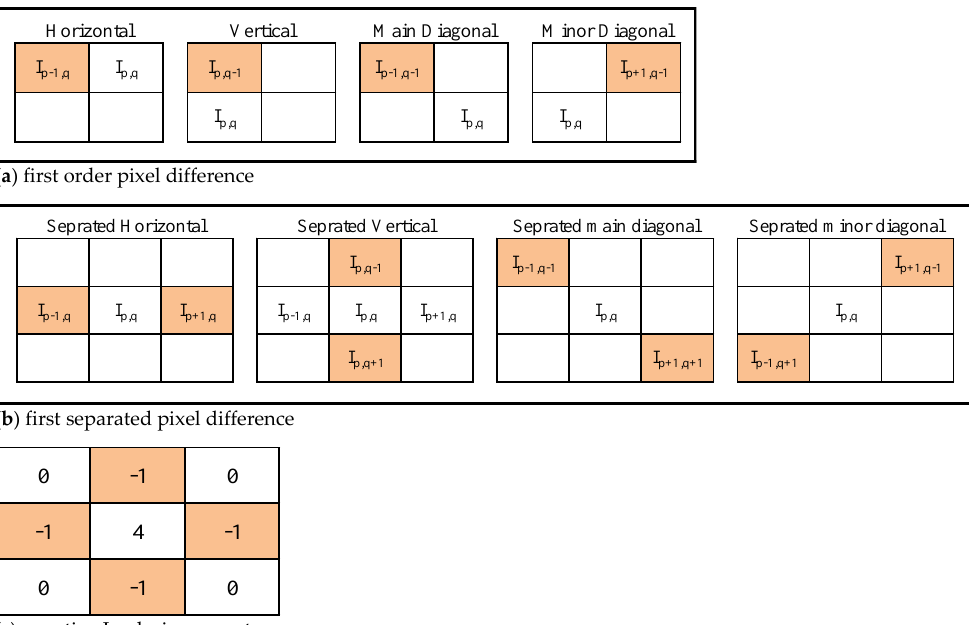
Figure 6. Image and their corresponding difference arrays: ( a ) color image; ( b ) grayscale image; ( c ) first order difference array; ( d ) second order difference array; ( e ) separated pixel difference array; ( f ) Laplacian difference array. Next, the second order Markov chain is extracted to identify the co-occurrences of difference pixel arrays. Before understanding the second order Markov chain, we have to